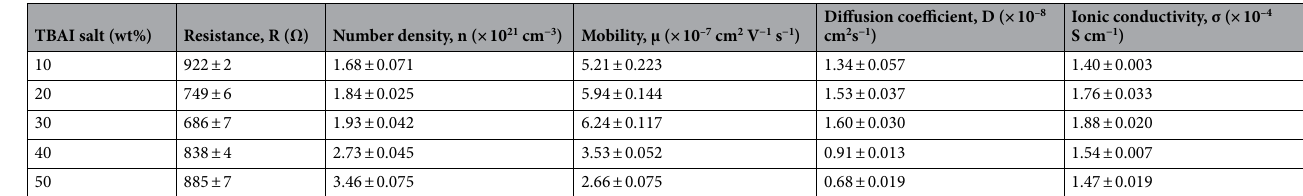
Table 2. Parameters of ionic conductivity with various weight percentages of TBAI salt added at room